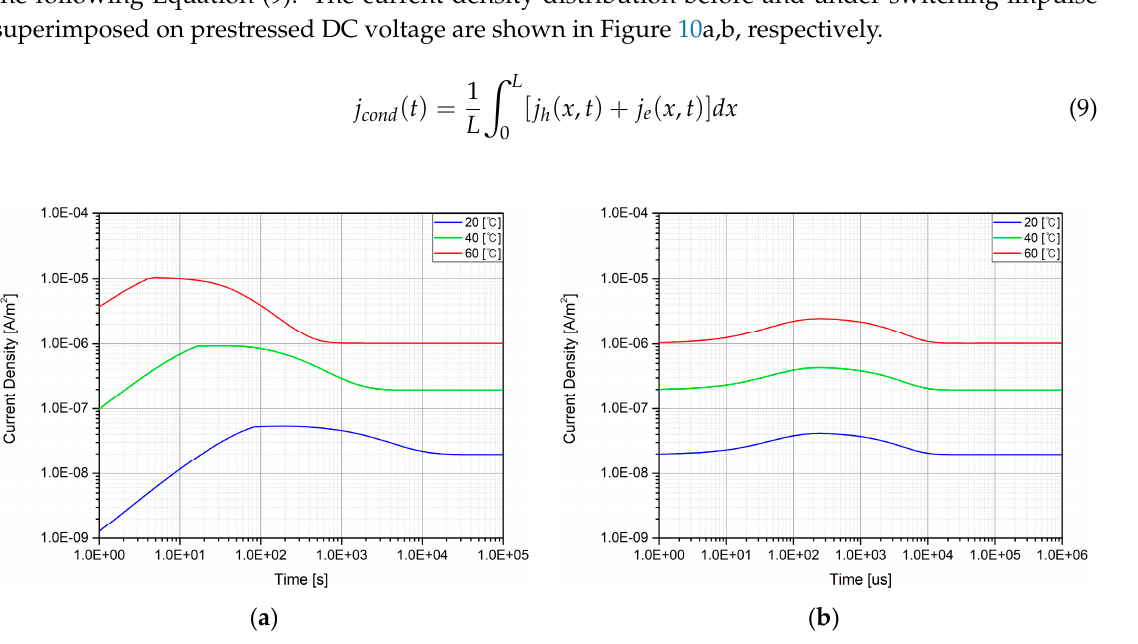
Figure 9. Mobile carrier density immediately after switching impulse is superimposed on prestressed DC voltage: (a) mobile electrons; (b) mobile holes.